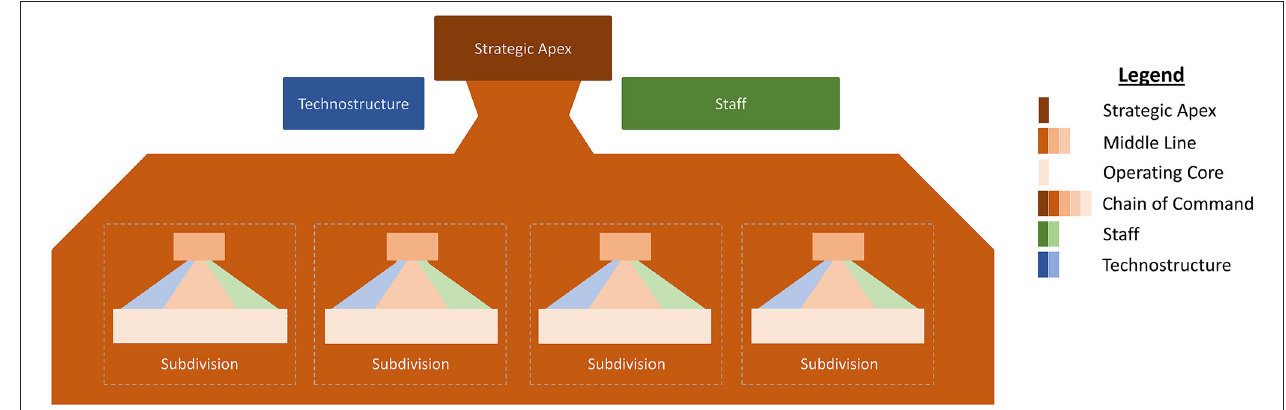
FIGURE 1 | Conceptual representation of divisionalized form adapted from Mintzberg